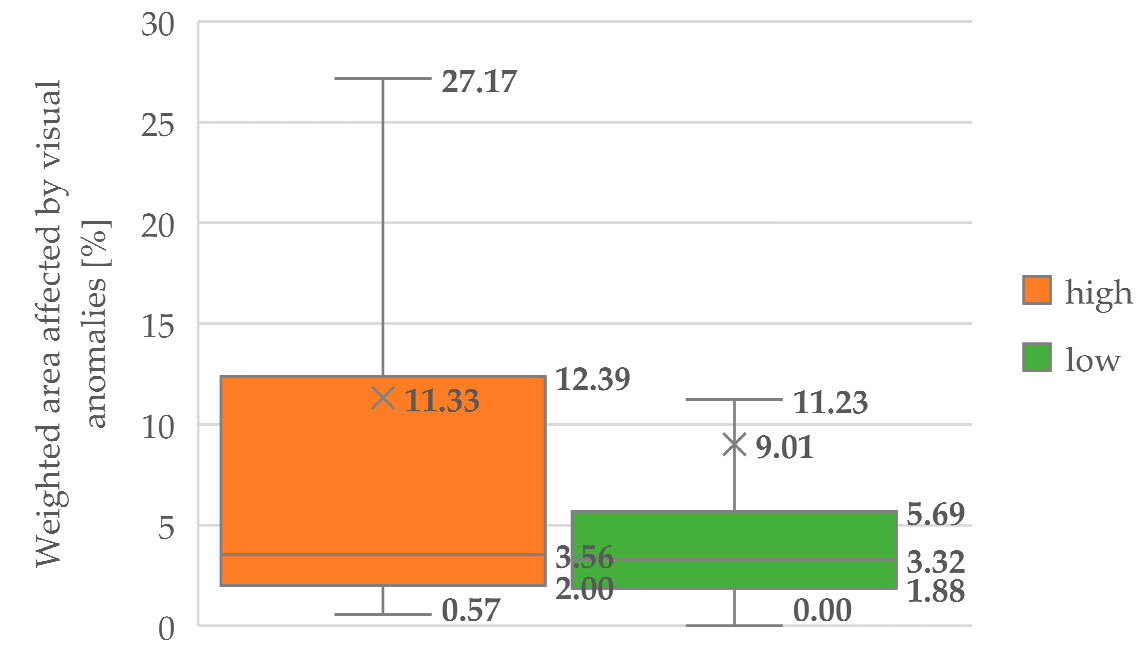
Figure 3. Boxplots of the weighted area of the façade affected by visual anomalies according to the buildings’ height.